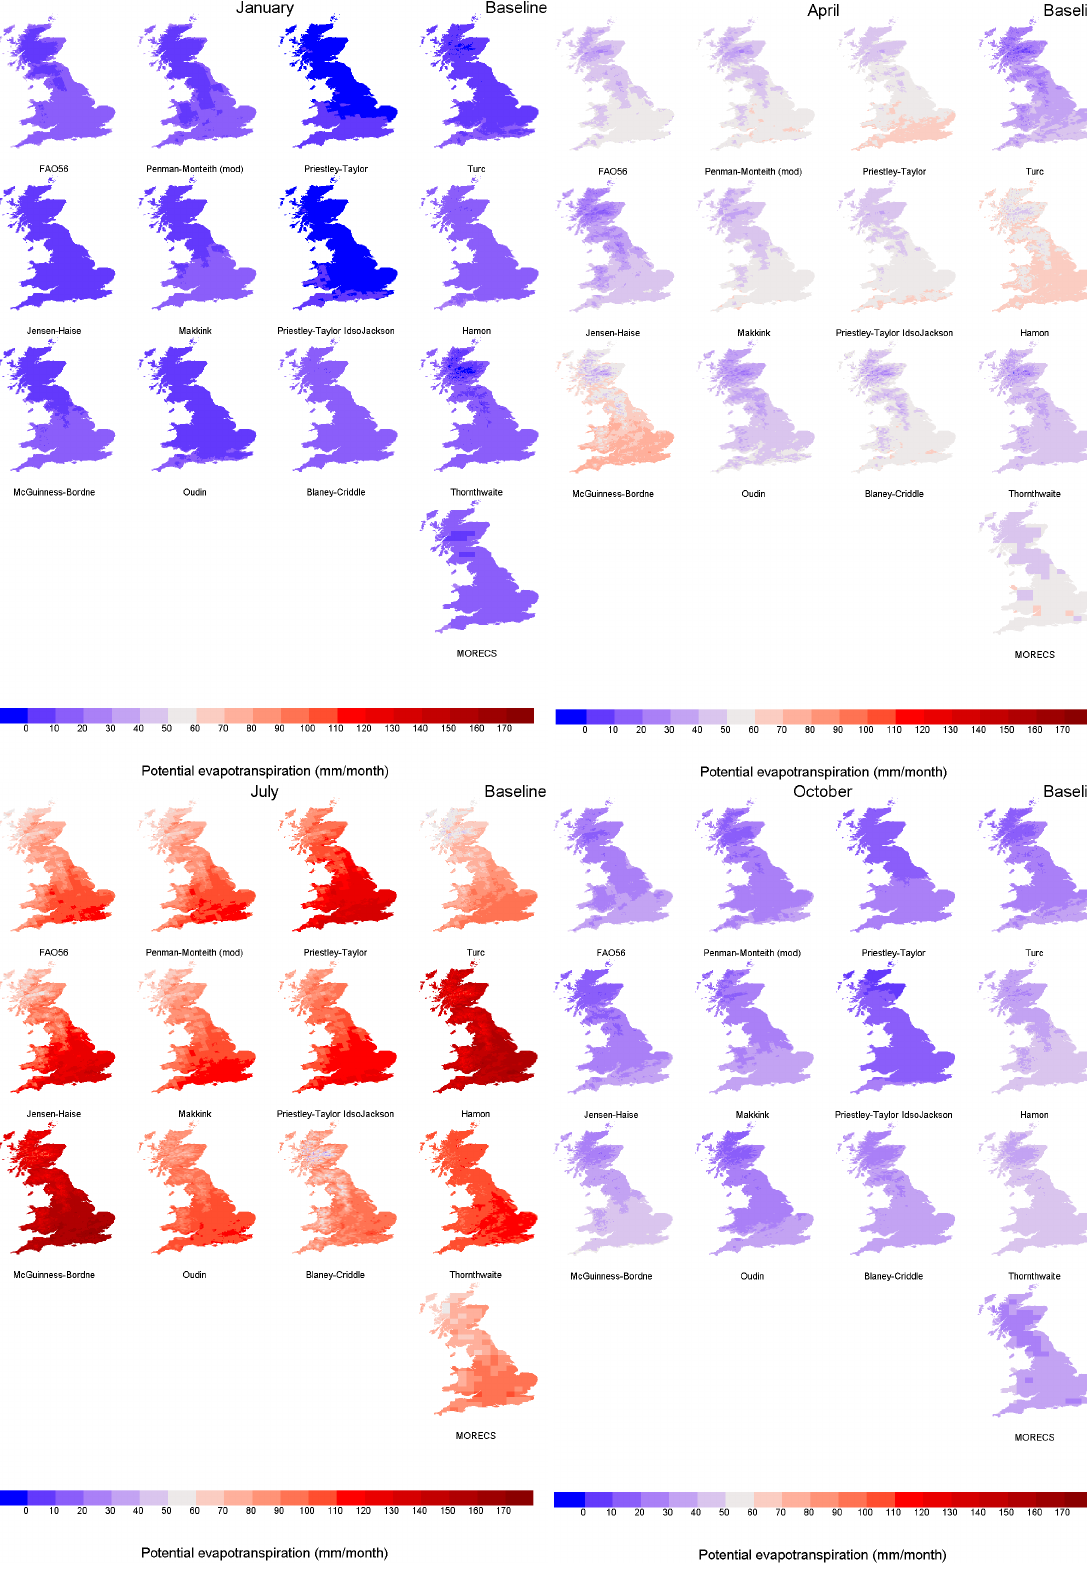
www.hydrol-earth-syst-sci.net/17/1365/2013/ Hydrol. Earth Syst. Sci., 17, 1365–1377,